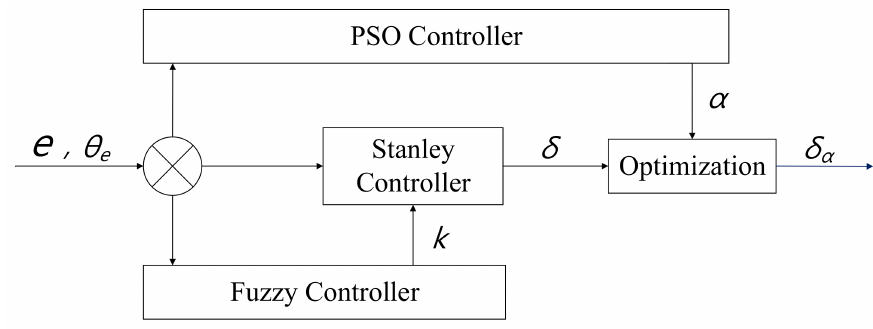
Figure 5. Input and output block diagram of